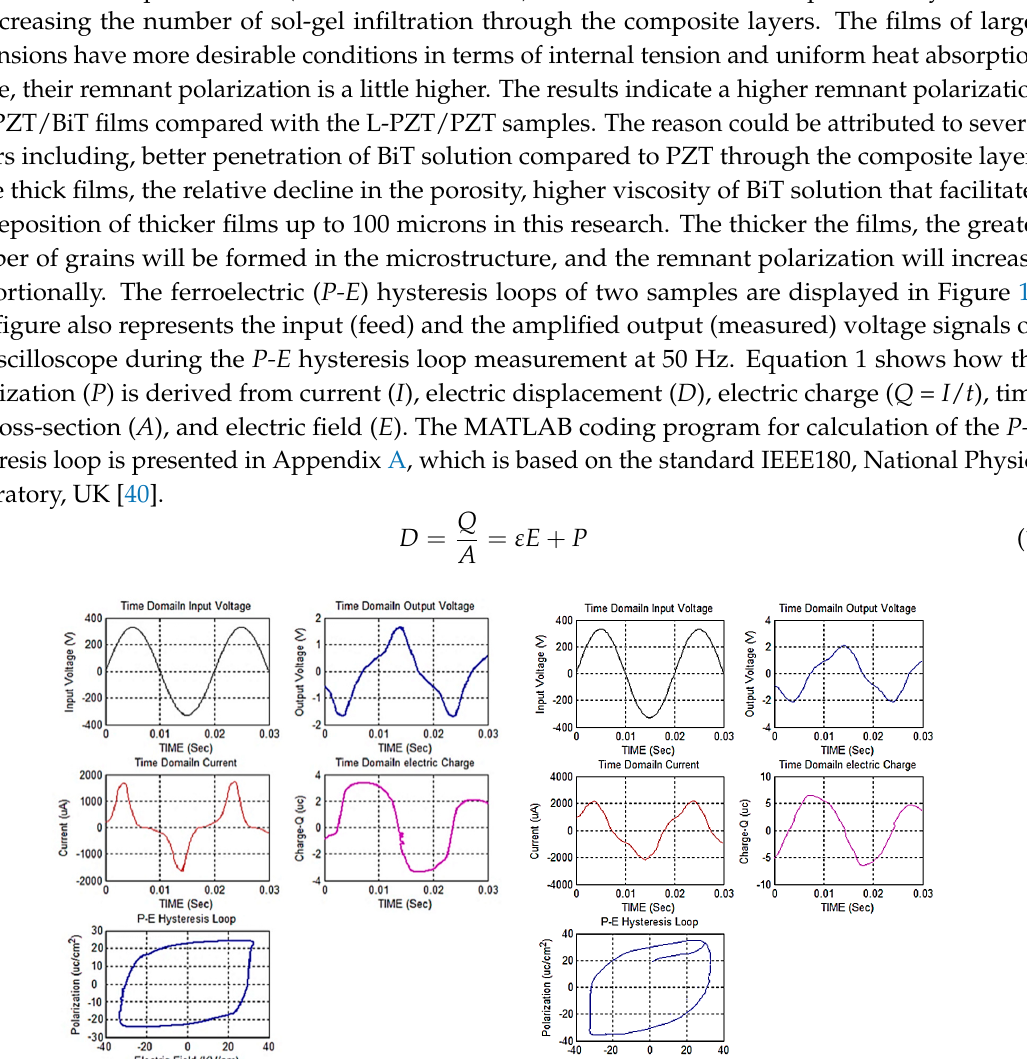
Figure 10. Variation of dielectric permittivity in piezoelectric composite films of [ k 1 C + k 2 S] structure.